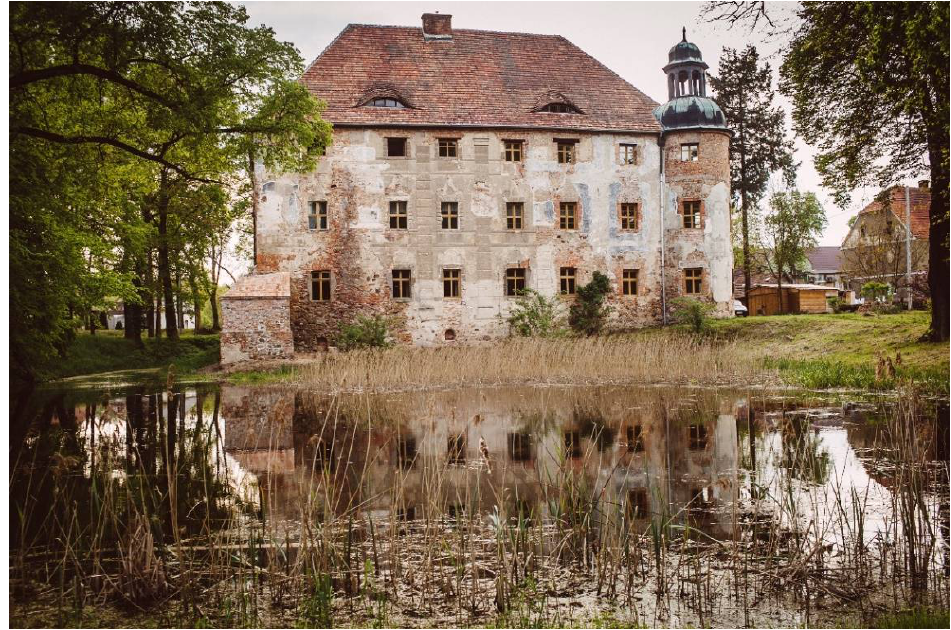
Figure 26. Palace in Broniszów. Photo by KingaLu, 2017. Source: Wikipedia. Zamek Broniszów staw.